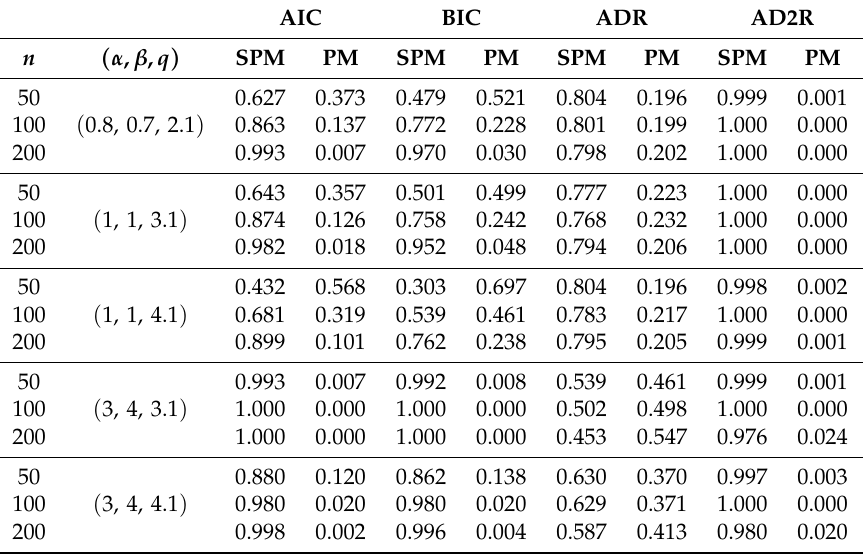
Table 5. SPM simulation, criteria